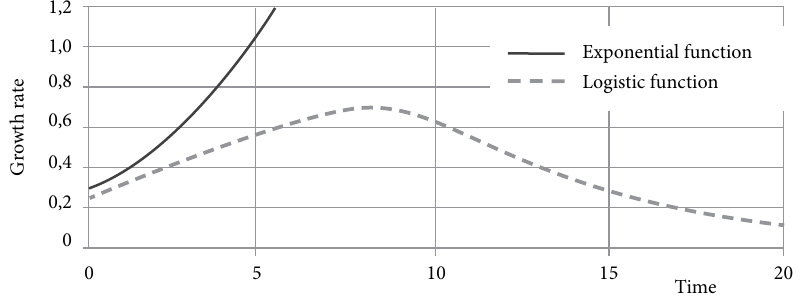
Fig. 2. Capital growth rate, calculated by 2 different functions. Interest rate 30%